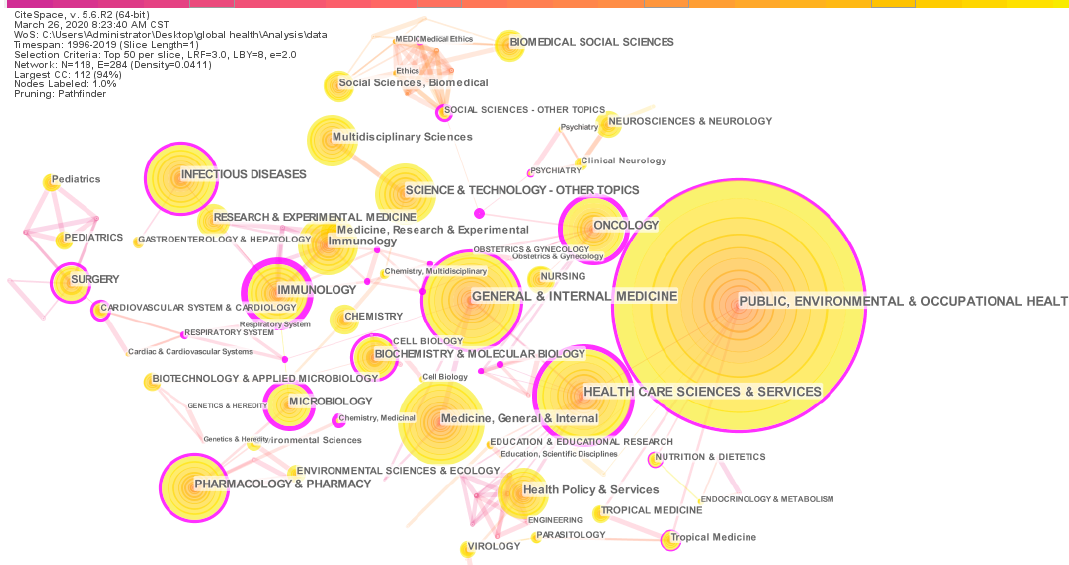
Figure 9. Knowledge map of co-occurrence categories. Table 8. The top 10 subject categories.